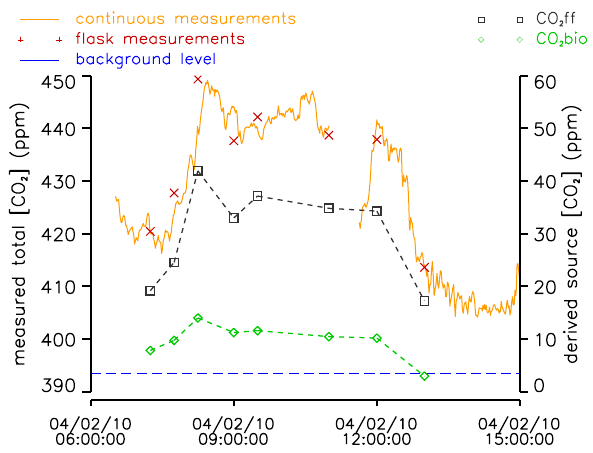
Fig. 6. A comparison between the continuous measurements for CO 2 (in orange) and the data obtained using flask sampling (red crosses) at the LHVP site are presented for 4 February 2010 on the left axis. We added the background level of CO 2 as measured at Mace Head (Ireland), which is represented by the blue horizontal dashed line. The figures for CO 2 ff and CO 2 bio, as derived from flask sampling, are represented on the right axis by the black and green curves, respectively. The left and right axes have the same CO 2